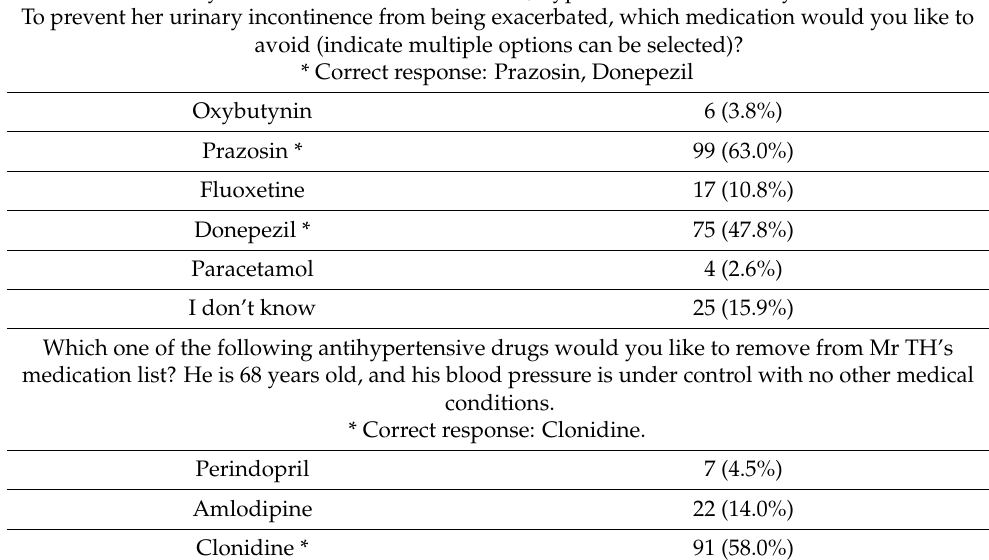
Table 3. Assessing pharmacists’ knowledge of PIM use based on clinical case